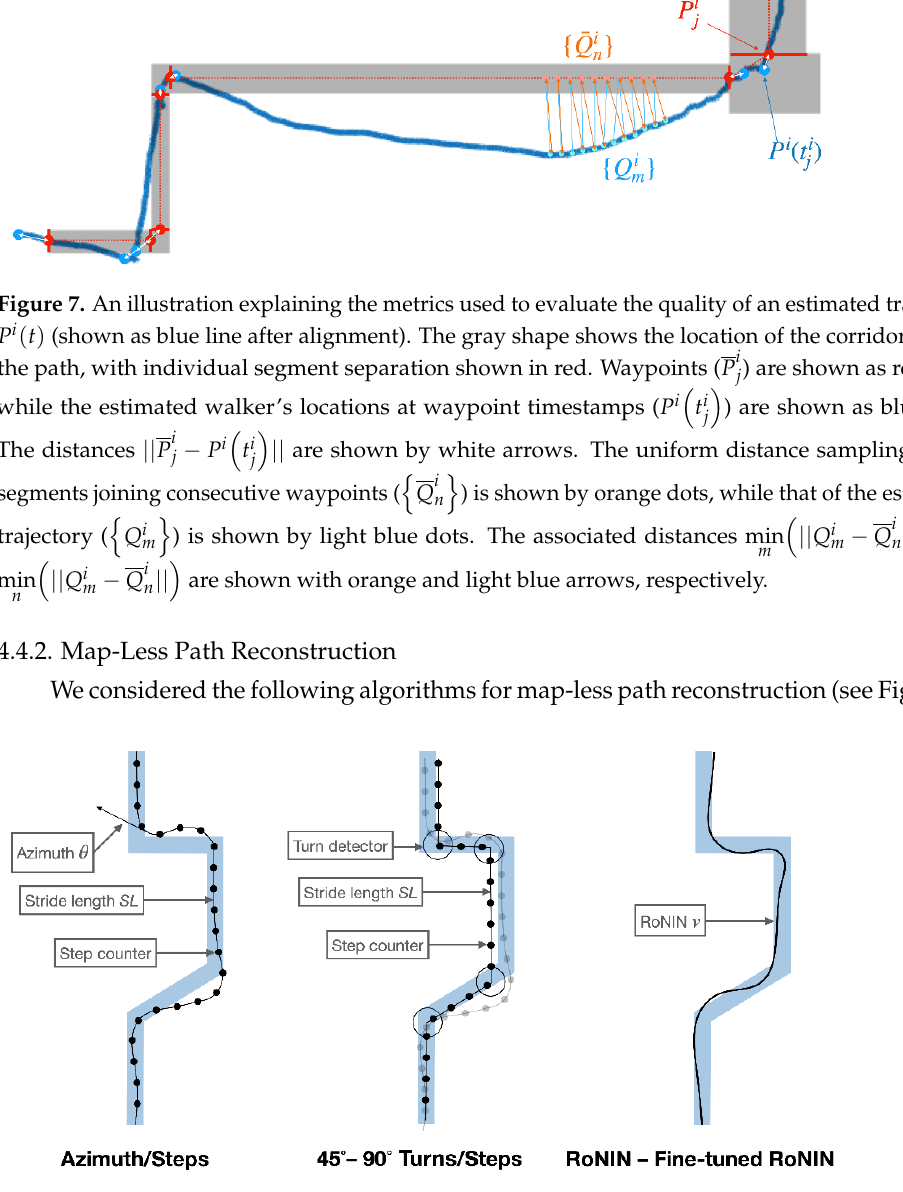
Figure 8. Diagrammatic examples of the algorithms used for map-less path reconstruction. The blue line represents the path taken by the walker. The black line represents the estimated path. Dots represent heel strikes; circles represent turns. Table 3. Reconstruction errors ( RMSE wp , Hauss, avHauss ) using the map-less path reconstruction algorithms described in Section 4.4.2. Units of meters. For each community of walkers (S, LC, DG), the smallest error values for each metric are shown in boldface.